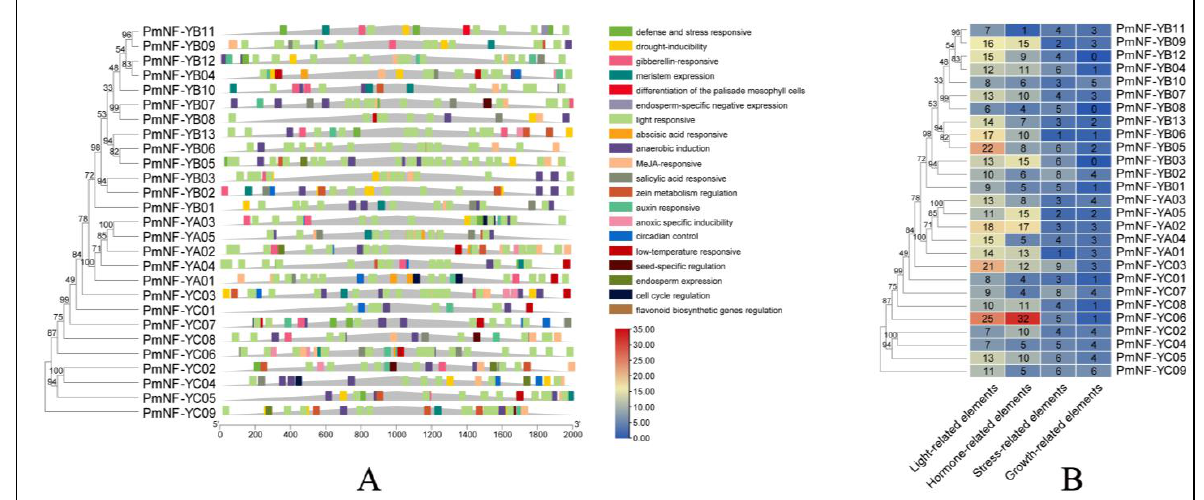
Figure 4. Predicted cis-acting elements in the promoters of PmNF-Y genes. ( A ) The 2000 bp sequences upstream of the 27 PmNF-Y genes were analyzed with PlantCARE. ( B ) Types and numbers of cis-acting elements in the promoter regions of PmNF-Y genes.